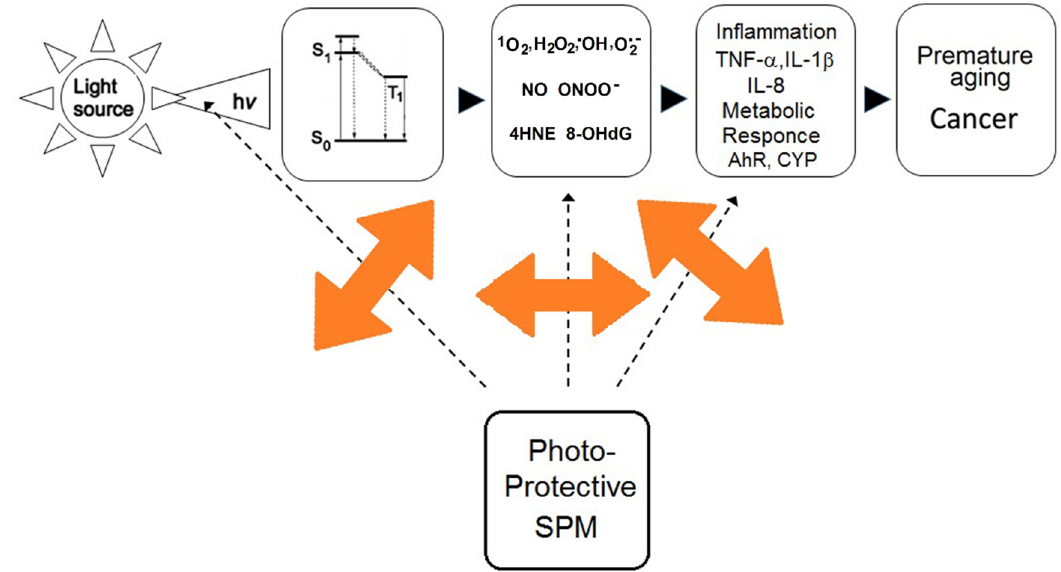
Figure 2. Modes of photo-protection by polyphenolic secondary plant metabolites. Physical photo- protection by interaction with UV light quantum (sunscreen), free radical scavenging, antioxidant, and singlet oxygen quenching (photo-chemical protection), and inhibition of inflammatory and metabolic skin responses to UV light (biological protection).